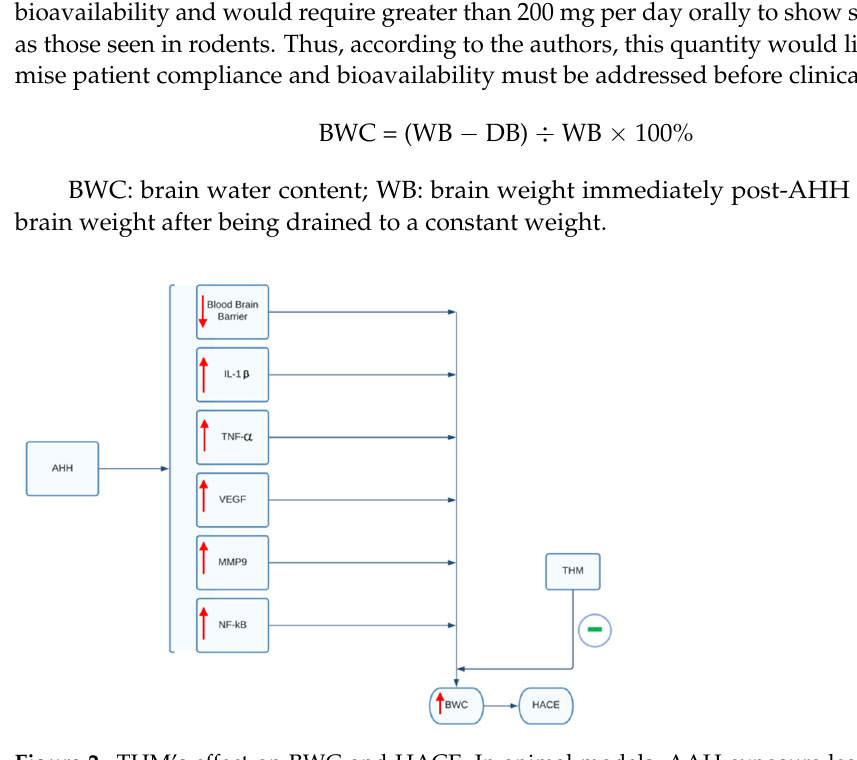
Figure 2. THM’s effect on BWC and HACE. In animal models, AAH exposure leads to a rise in inflammatory mediators and decrease in blood-brain barrier integrity, as indicated by the red arrows. These alterations lead to a rise in BWC. As indicated by green symbol, administration of THM can attenuate the rise in inflammatory mediators and blood-brain barrier breakdown. Ultimately, this prevents increases in BWC and subsequent development of HACE. AAH, acute hypobaric hypoxia; IL-1 β , interleukin-1 β ; TNF- α , tumor necrosis factor- α ; VEGF, vascular endothelial growth factor; MMP9, matrix metallopeptidase; NF-kB, nuclear factor kappa-light-chain-enhancer of activated B cells; BWC, brain water content; THM, tetrahydrocurcumin; HACE, high-altitude cerebral edema.